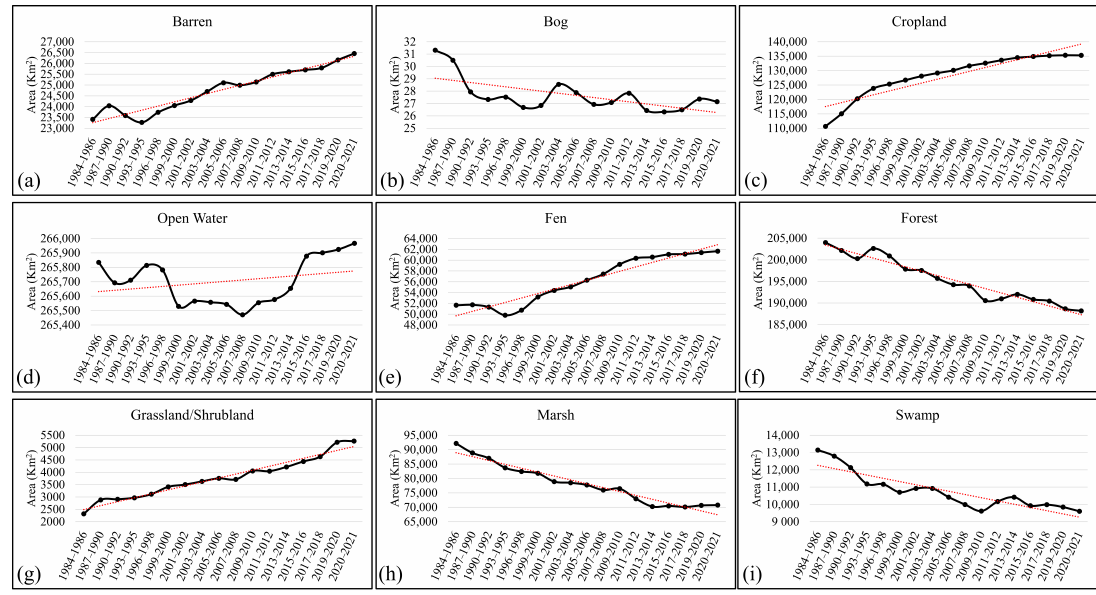
Figure 13. Variation of the areas of the classes in the Great Lakes basin extracted from the correspond- ing wetland maps from 1984 and 2021. ( a – i ) respectively provide the results for the Barren, Bog, Cropland, Open Water, Fen, Forest, Grassland/Shrubland, Marsh, and Swamp classes. The black and red lines indicate the line chart and linear regression trendline, respectively.